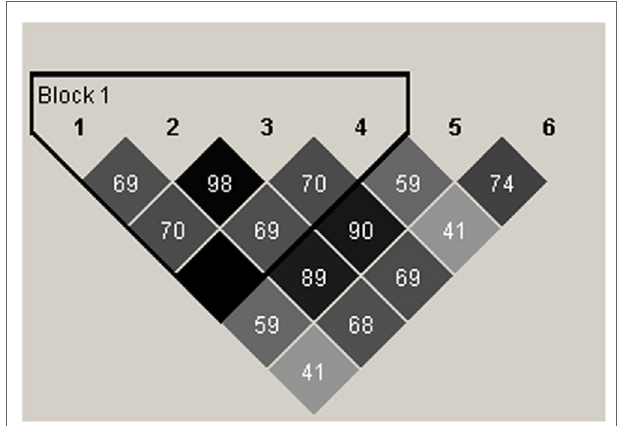
FigUre 8 | schematic representation of linkage disequilibrium (lD) between RGS4 snPs in the scZ, BPD, and nc groups . The LD block (thick black outline) consisting of four SNPs spans < 1 kb (hence the Haploview program shows it as 0 kb). The number shown in each box in the figure corresponds to r 2 which measures LD. r 2 Values were calculated from the genotype data from the entire samples by Haploview. 1 = rs10917670 (SNP1), 2 = rs2661347, 3 = rs951436(SNP4), 4 = rs951439(SNP7), 5 = rs2661319(SNP18), 6 =